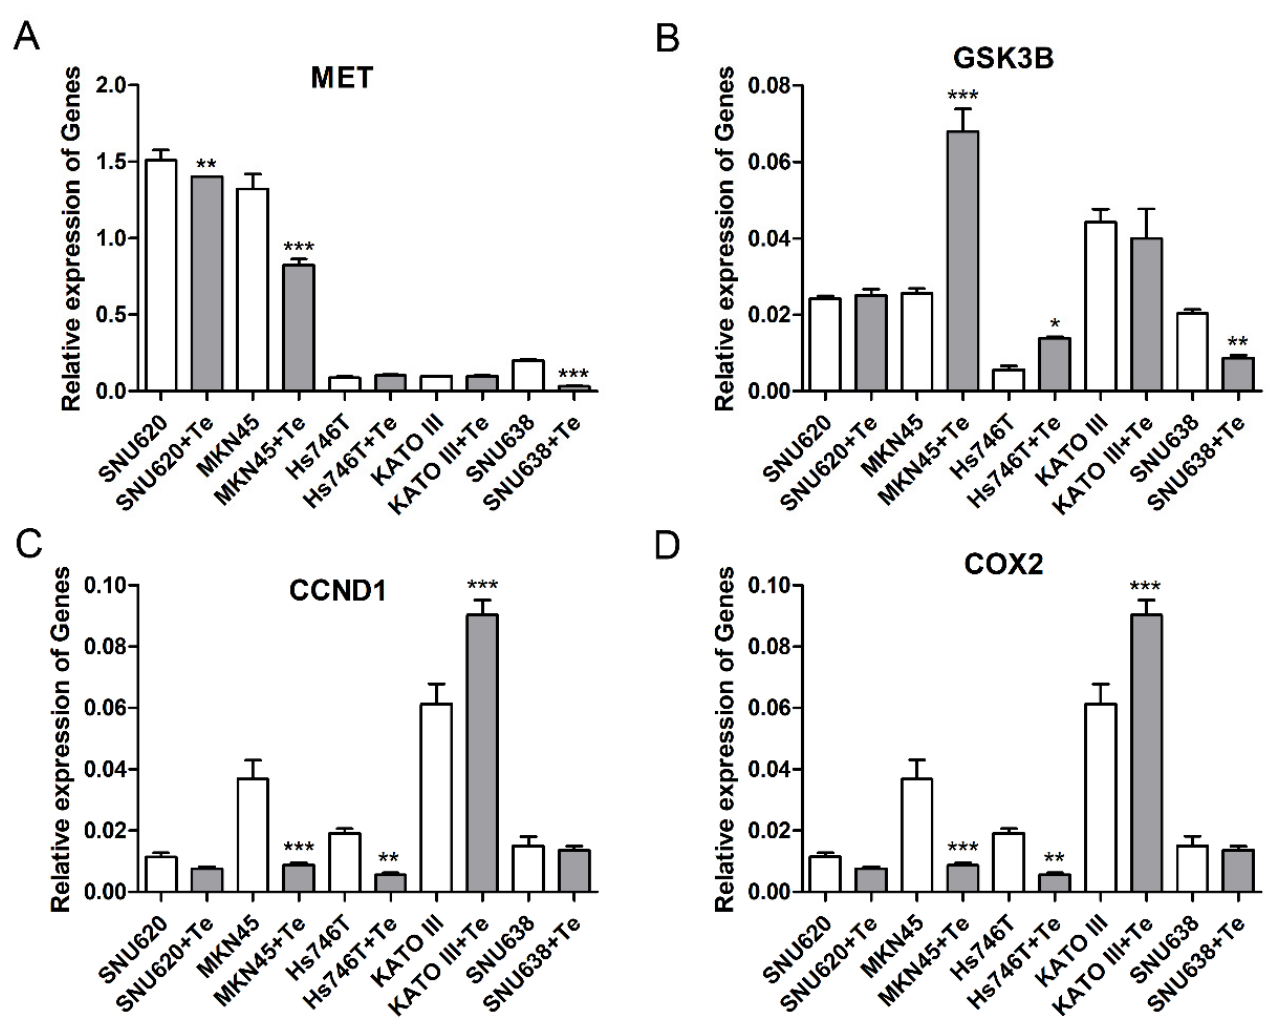
Figure 4. Effects of tepotinib on gene expressions of ( A ) MET, ( B ) GSK3 β , ( C ) CCND1, and ( D )